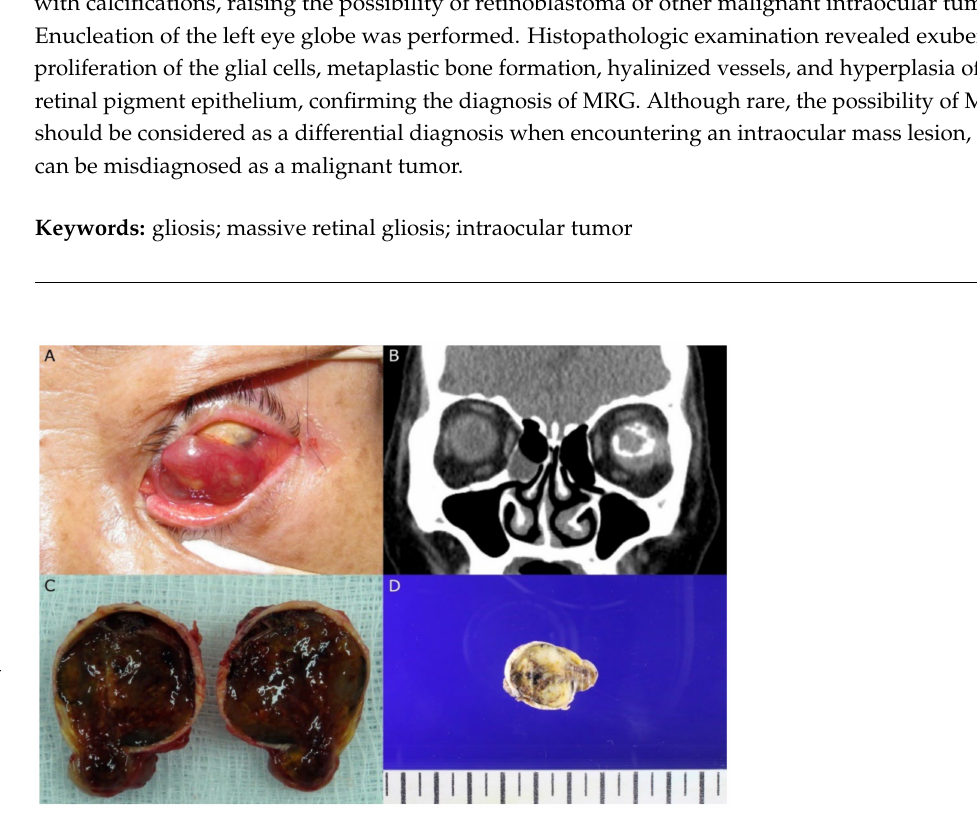
Figure 1. A 70-year-old female presented with a protruding mass lesion in her left eye. The mass had been growing slowly for several months. She had a history of phthisis bulbi due to trauma during childhood. ( A ) Ocular examination revealed a protruding mass lesion in the left eye with phthisis bulbi. ( B ) An intraocular mass filling the entire vitreous cavity was shown on orbital CT. Intratumoral calcification was noted. Initial impression was a malignant intraocular tumor such as retinoblastoma or uveal melanoma. ( C ) Enucleation of the eye was performed. A 2.7 × 2.3 cm sized mass